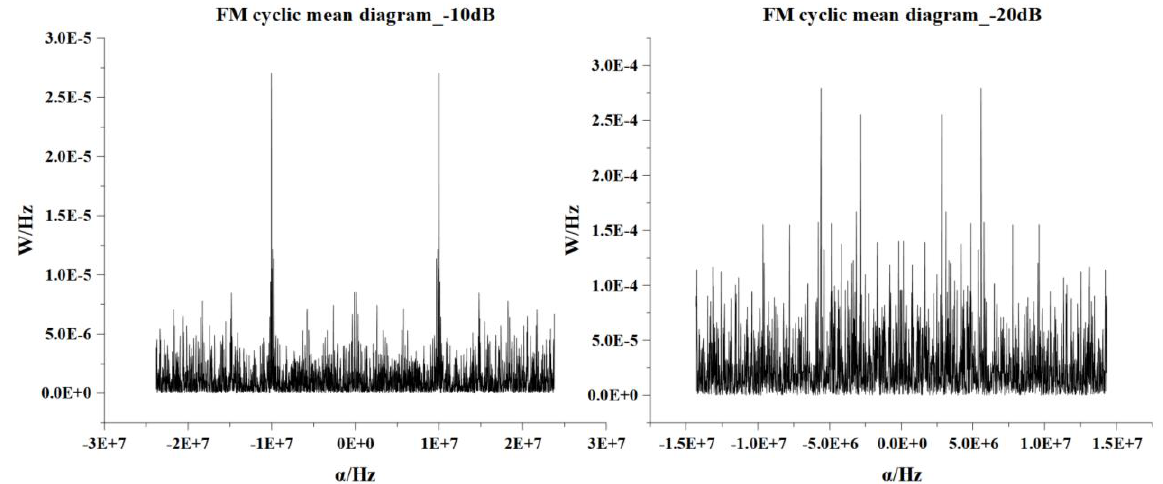
Figure 4. The cyclic mean of the FM signal under different